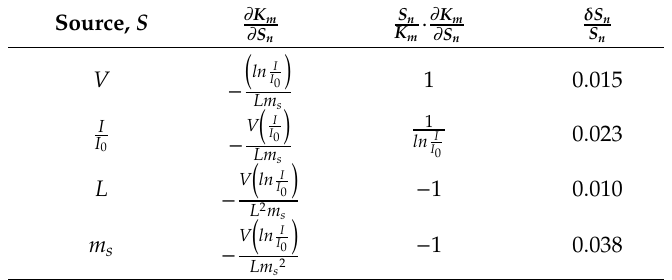
Table 1. Summary of Type B uncertainties in the mass specific extinction measurement. Source,